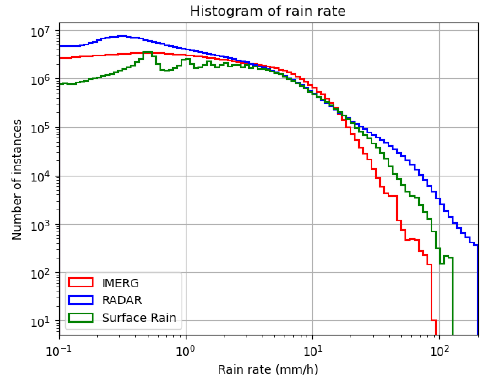
Figure 2. The number of pixels for each rain rate from IMERG, radar, and surface observations in RAIN-F+ dataset.